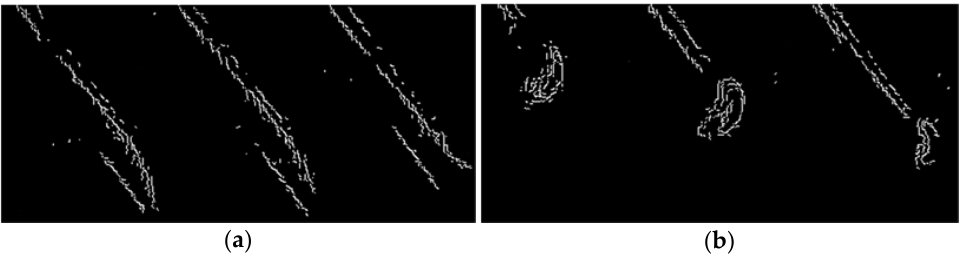
Figure 4. ( a ) Normal contour line of metal transfer; ( b ) abnormal contour line of metal transfer. To detect the defects, the bead shape should be verified. The quality of the bead shape is affected by various process parameters (e.g., arc current, wire feed rate, and travel speed). If these process parameters are incorrectly set [45,46], defects such as humping can occur [47,48]. Nguyen et al. [49] limited the range of the torch traveling speed during the